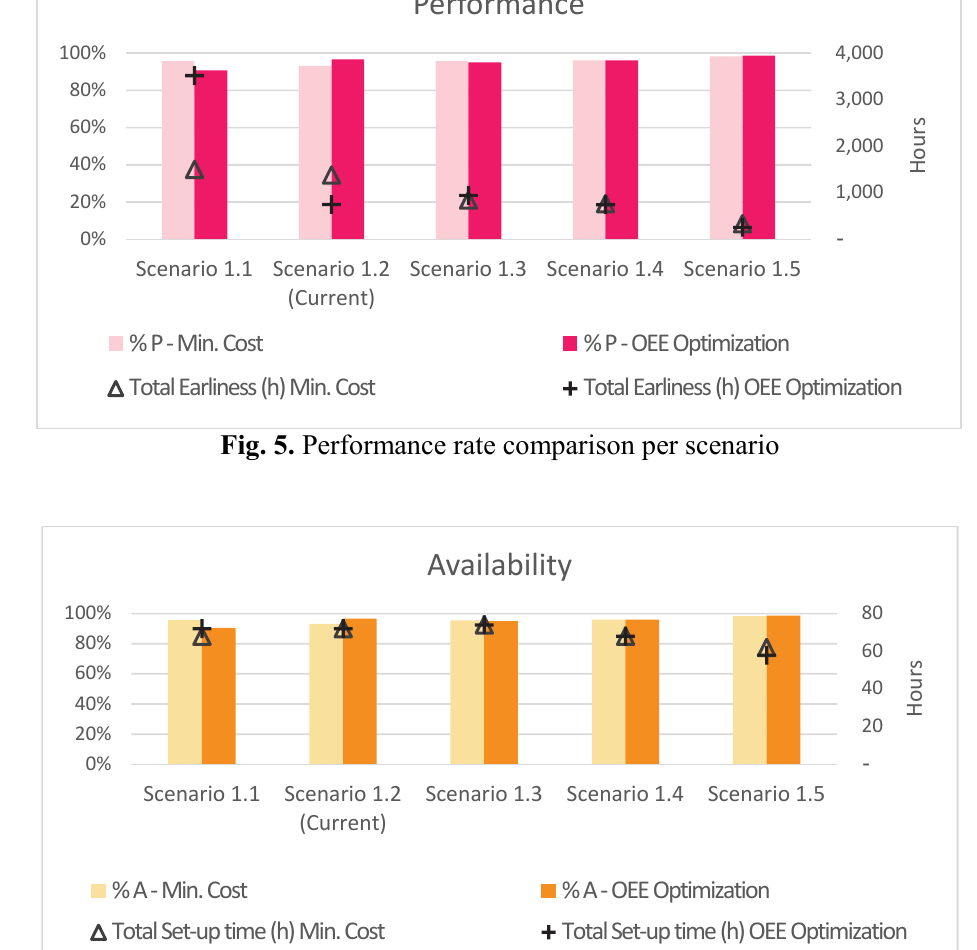
Fig. 6. Availability rate comparison per